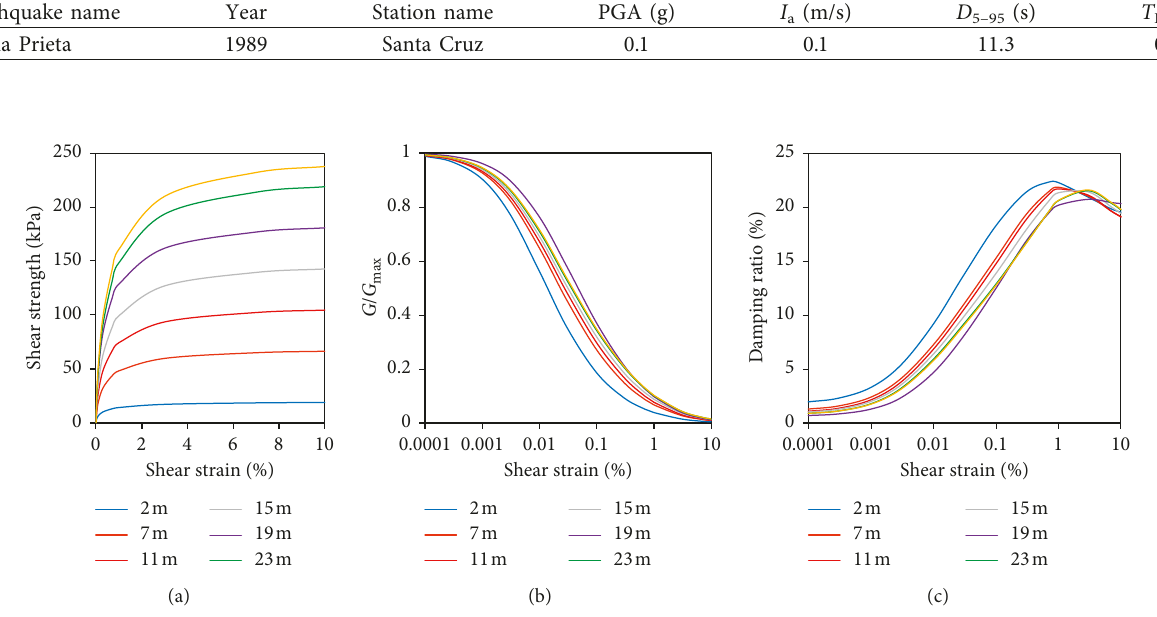
Figure 5: Calibrated nonlinear soil properties, (a) shear stress versus strain, (b) modulus reduction versus strains, and (c) damping versus strain curves